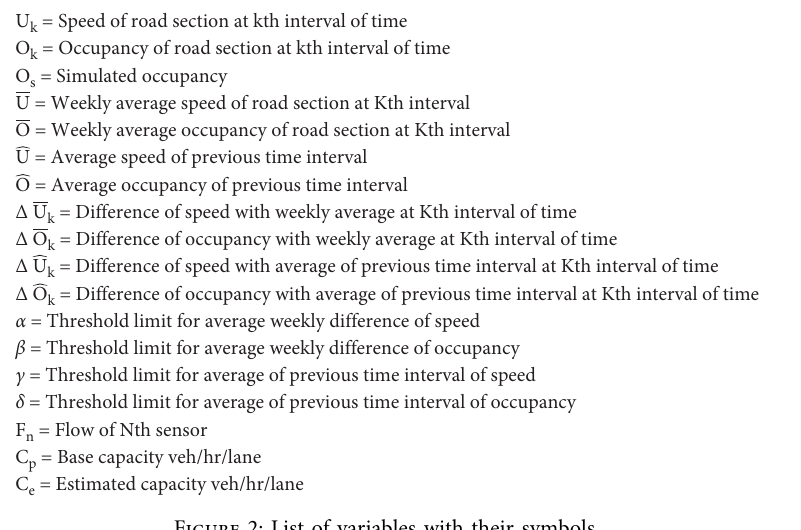
Figure 2: List of variables with their